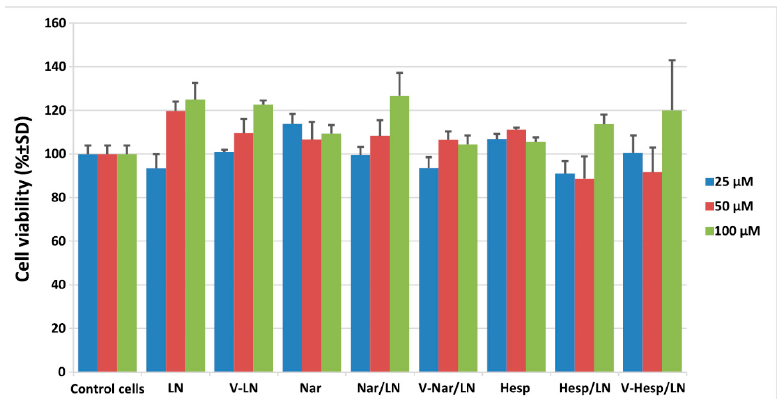
Figure 3. Viability of EA.hy926 cells exposed for 24 h to different concentrations of flavonoid-loaded lipid nanoemulsions or to corresponding concentration of free flavonoids, assessed by XTT assay.